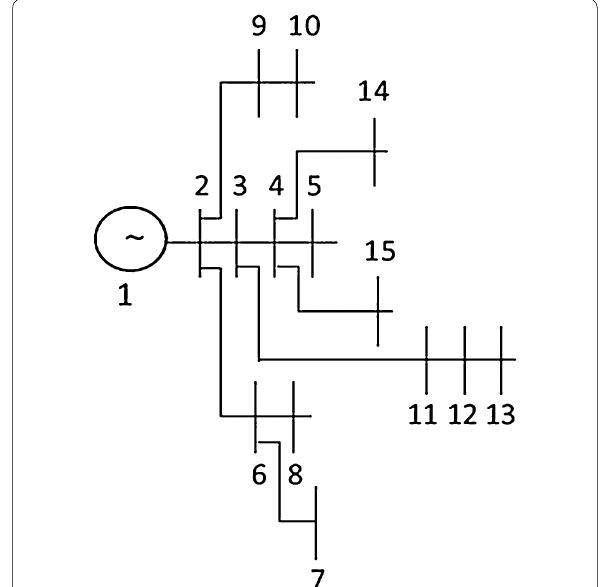
Fig. 2 Single-line diagram of 15-bus system